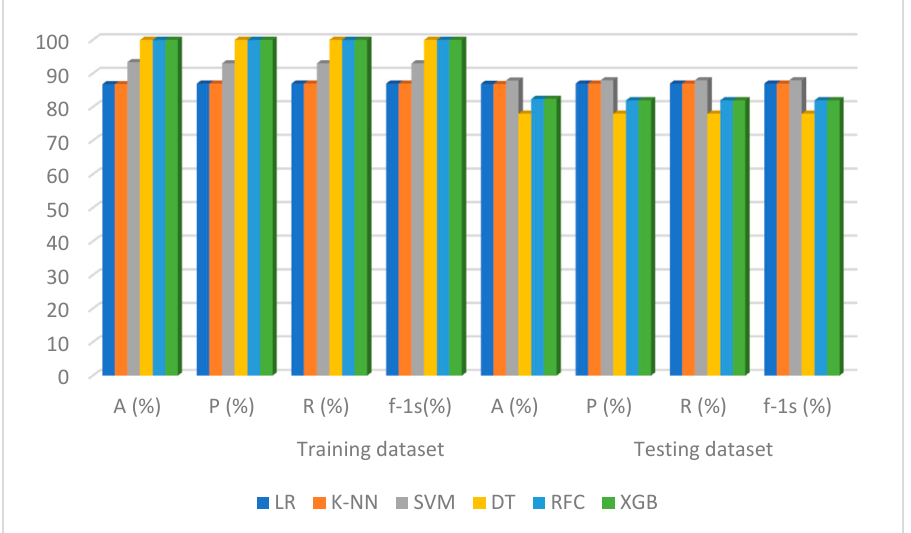
Figure 5. Graphical representation of the performance evaluation of the traditional system.